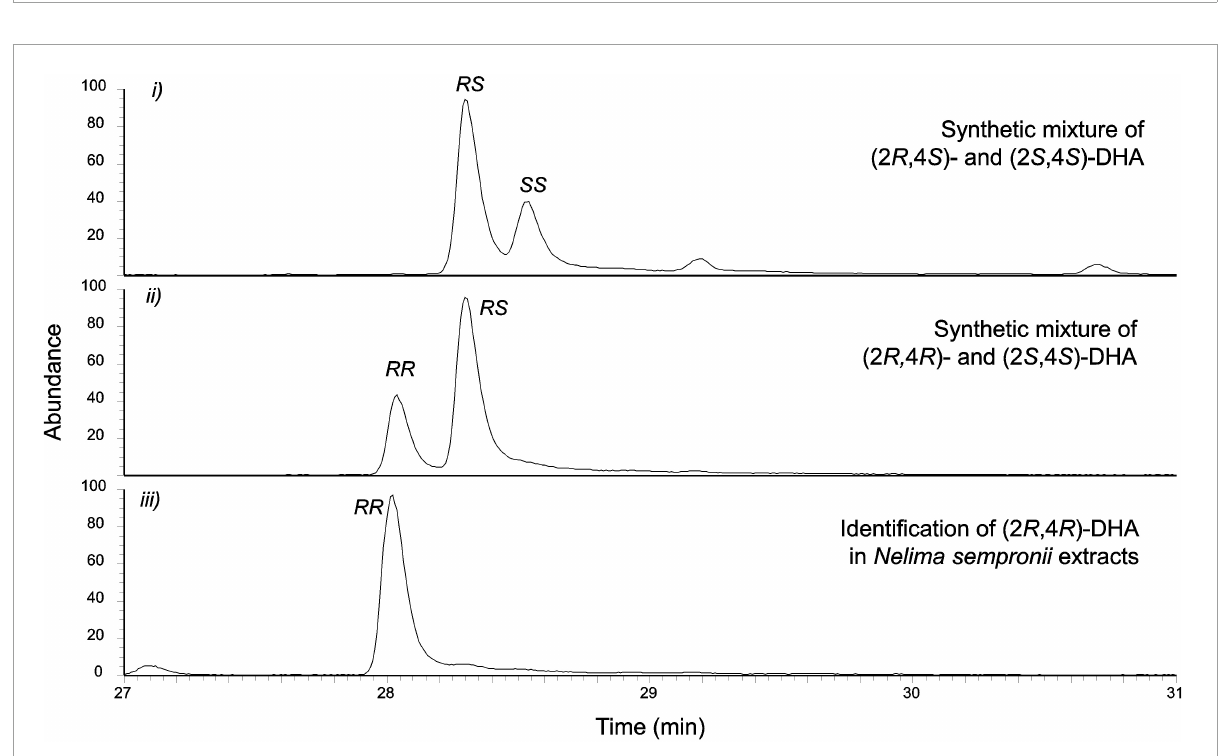
FIGURE7 Absolute configuration of 2,4-dimethylhexanoic acid (DHA, compound C) in the extracts of Nelima sempronii . Identification of (2 R ,4 R )-2,4-dimethylhexanoic acid (2 R ,4 R -DHA) using a chiral ß-cyclodextrin-phase.